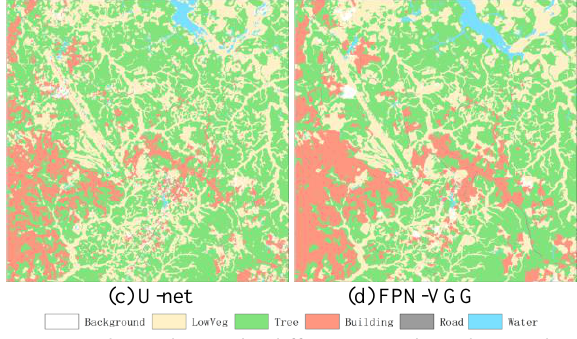
Figure 6. The predictions by different networks with input data of RGB images